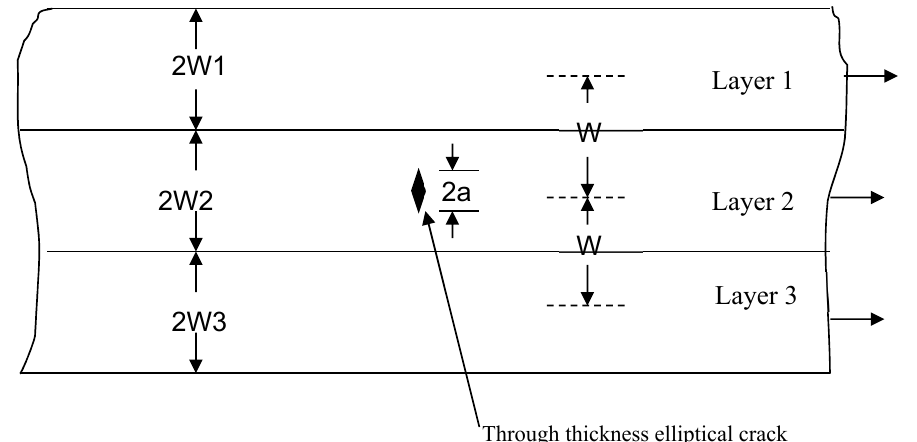
Figure 8. 2D cross-sectional plane through three FGM layers and the two interfaces—a layer containing the elliptical crack of length, 2a (layer 2), and two layers adjacent to it.